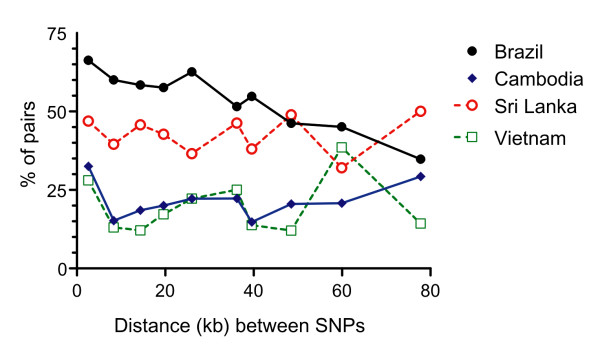
Proportions of informative SNP pairs that display significant LD plotted at various intermarker distances. Data are shown for Brazil (Granada, Plácido de Castro and Porto Velho combined), Cambodia, Sri Lanka, and Vietnam. Pairwise physical distances between markers (in kb) were divided into deciles; the average distance within each decile is used to plot values. Note that the proportion of pairs with significant LD decreases with intermarker distance only in Brazil.